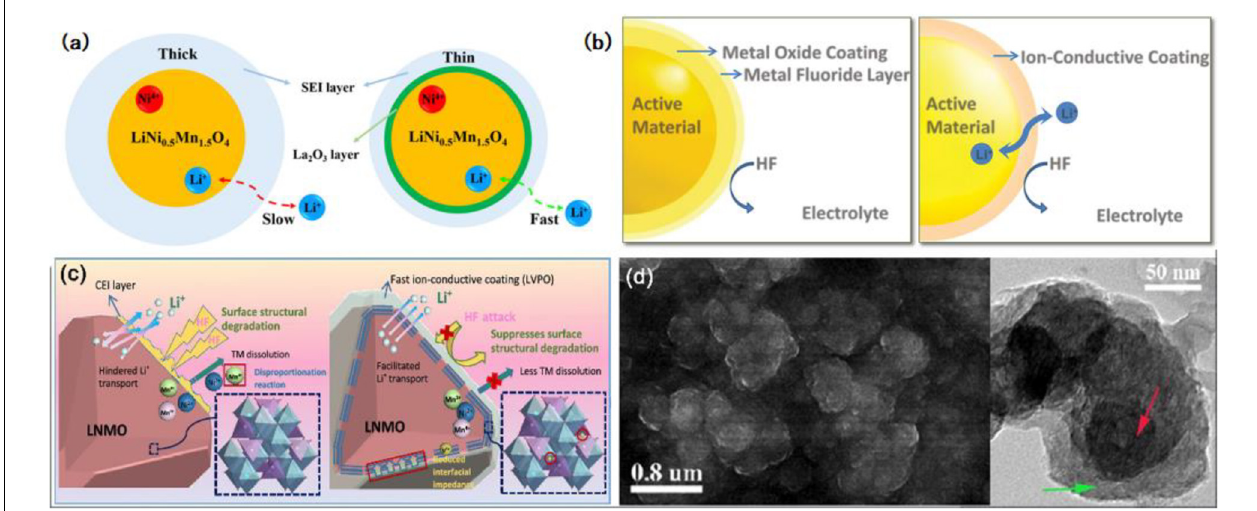
FIGURE 6 | The functioning mechanism of surface modification-surface coating. (a) Schematic illustrations of the cycled La 2 O 3 -coated LNMO and the functioning mechanism of the La 2 O 3 protective layer. Ref. Gao et al. (2020). Copyright 2020 Elsevier. (b) Schematic drawing of the interface between the positive electrode and electrolyte, the functioning difference between metal oxide coating (left) and ion-conductive coating (right). Reproduced with permission from Ref. Wang et al. (2015). Copyright 2015 Wiley-VCH. (c) The functioning process of surface modification to stabilize the surface of the LNMO particle. Reproduced with permission from Ref. Zhao R. et al. (2019). Copyright 2019 American Chemical Society. (d) The high-magnification SEM image (left) and TEM image (right) of the Si@PPy-Fe electrode after 10 cycles, and the Si nanoparticles (red arrow) were coated with a uniform PPy-Fe layer (green arrow). Reproduced with permission from Ref. Zhou et al. (2016). Copyright 2016 American Chemical